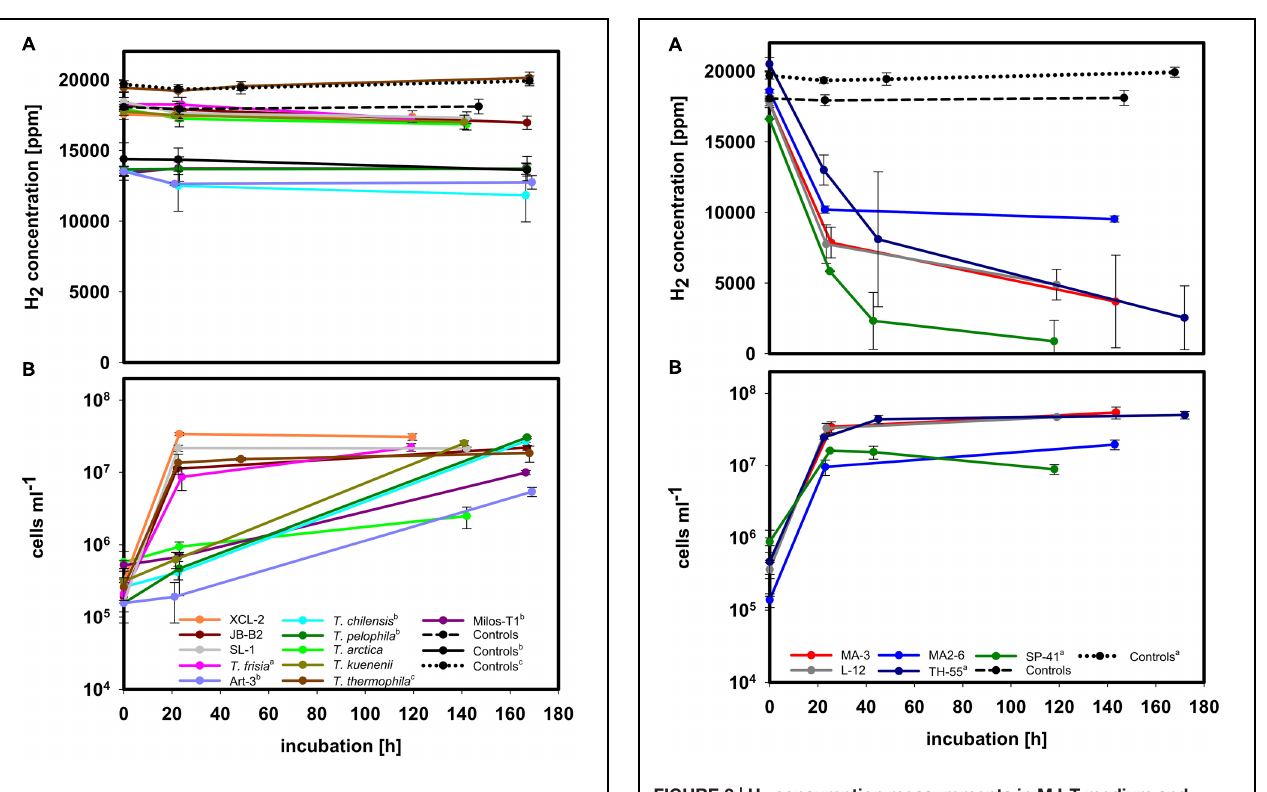
2016), we tested XCL-2 for hydrogen consumption under various conditions, i.e., in our standard medium MJ-T, without thiosulfate with and without added cysteine, varying